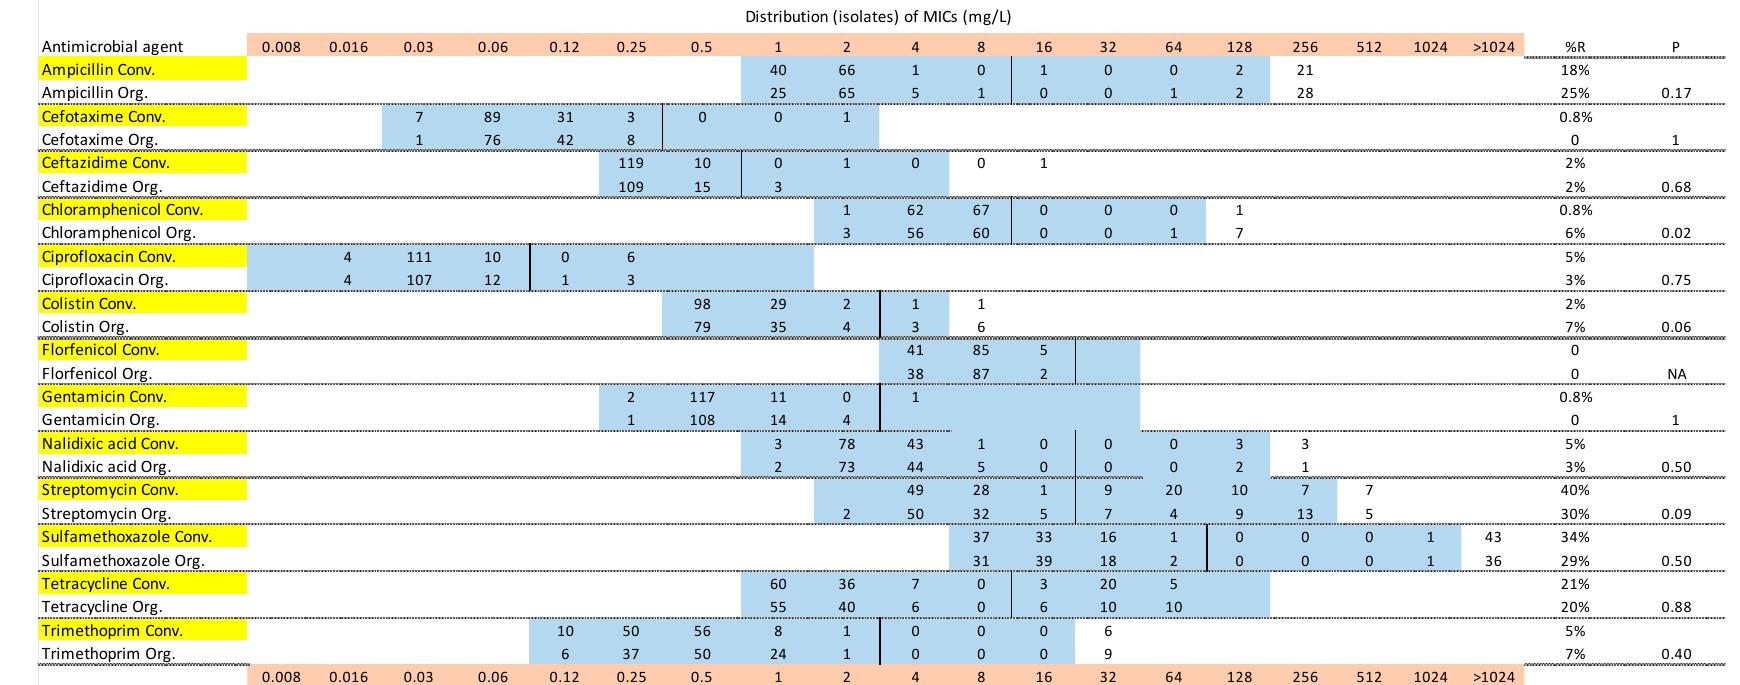
Figure 2. Minimum inhibitory concentration (MIC) distributions of Escherichia coli isolates from calves, sampled in period 2, in 27 (127 isolates) organic (Org) and 27 (131 isolates) conventional (Conv) Swedish dairy herds, in a panel of 13 antimicrobial agents. Blue color indicates the range of concentrations tested. Vertical black lines are the epidemiologic cut-off points according to EUCAST. p values test the difference between organic and conventional herds with Fisher’s exact test. Yellow color denotes isolates from conventional herds and pink color shows MIC values.